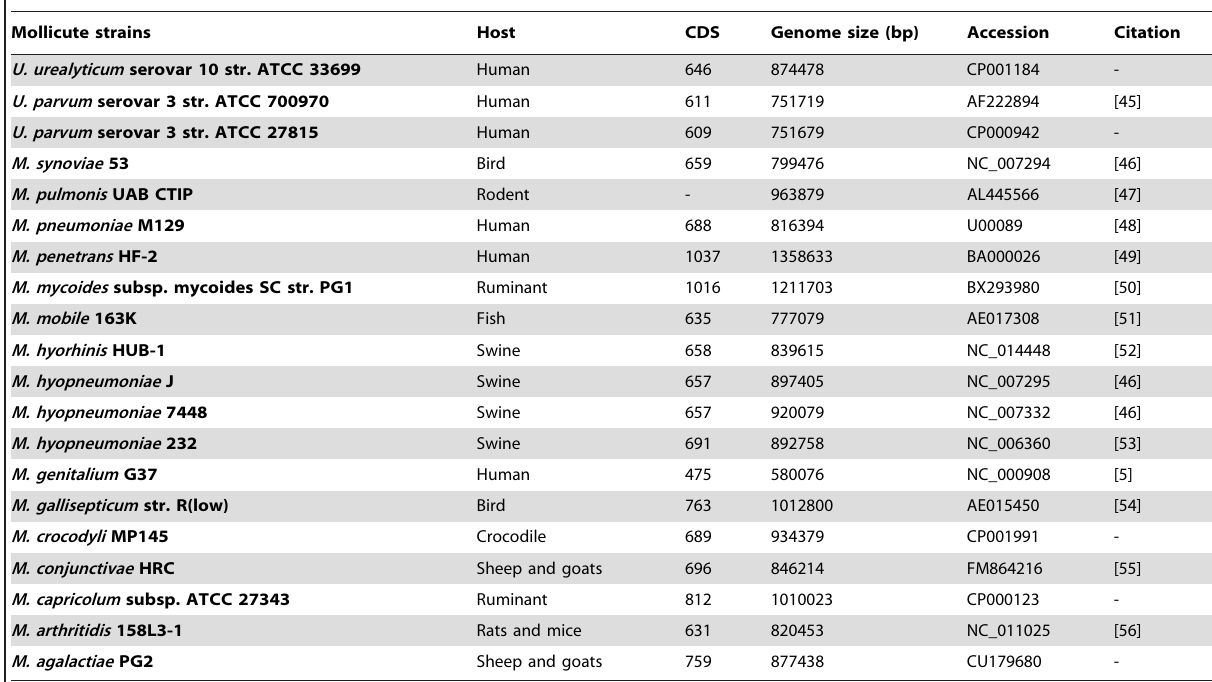
Table 1. Bacterial Strains Used in This